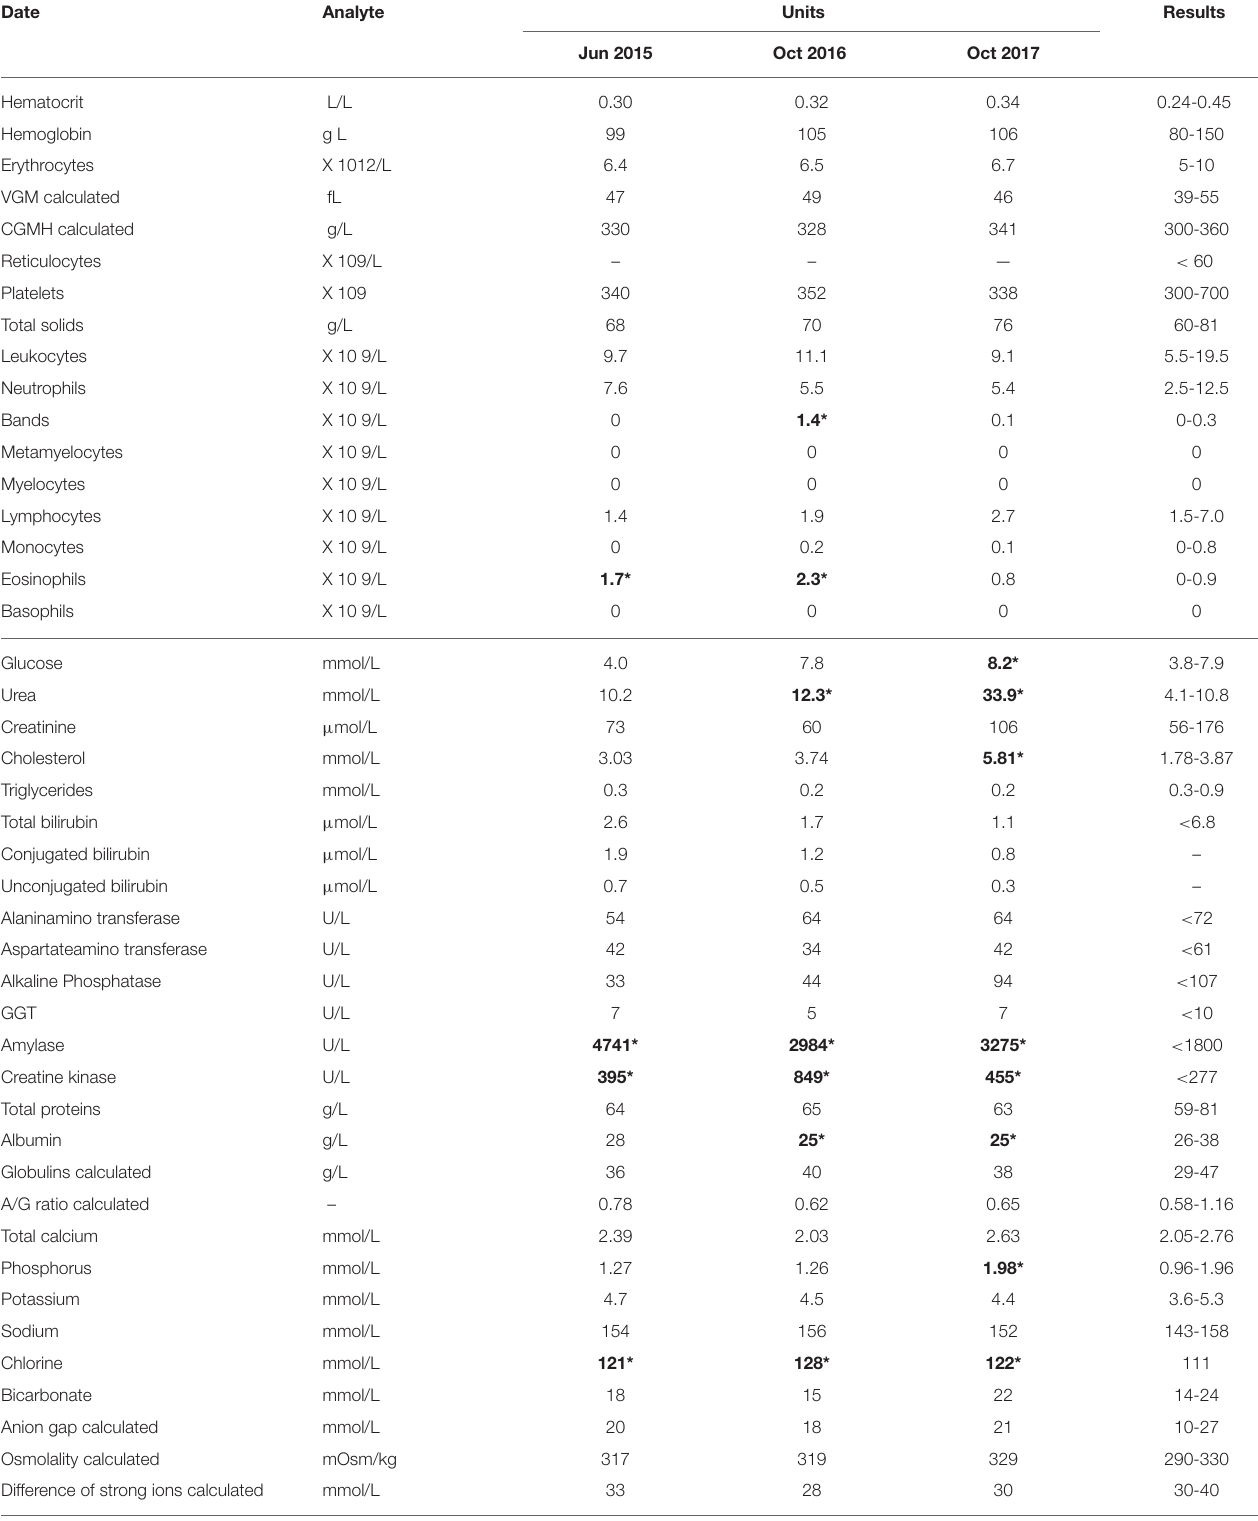
TABLE 1 | Hemogram, urinalysis and complete laboratory